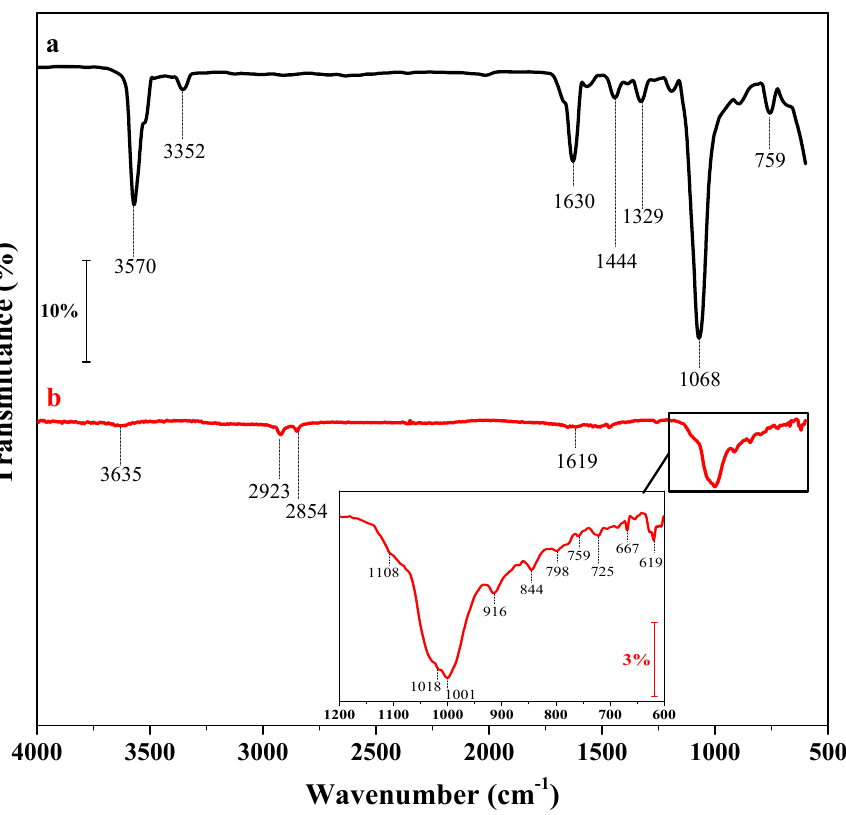
Figure 4. FTIR spectrum of the GCE modified with ( a ) electropolymerized COOH-PPy and ( b ) NH 2 -NCY . ( b ) NH 2